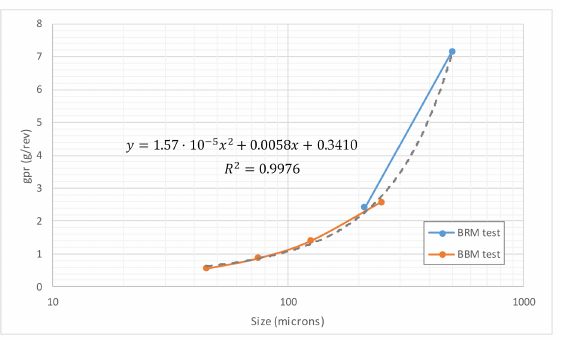
Figure 3. Variation of BBM and BRM gpr values with P 100 , Penouta tailings pond ore.